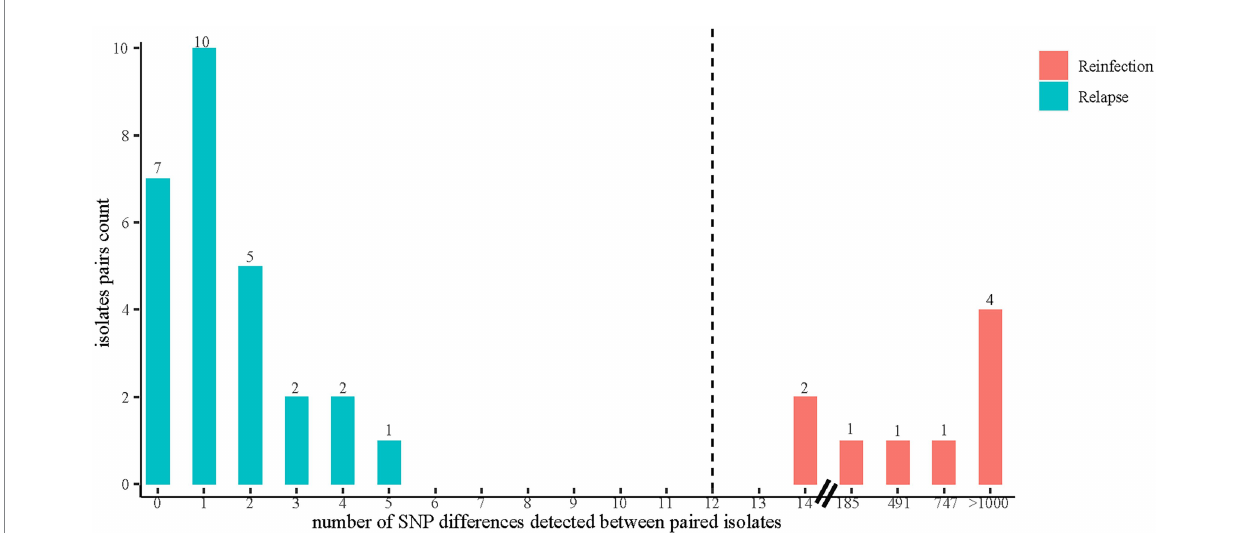
FIGURE 2 The distribution of SNP differences between paired isolates. Reinfection was defined as a recurrent disease episode caused by a new TB strain with a genetic distance of more than 12 SNPs compared with the strain that caused the original episode. Relapse was defined as a genetic distance of 12 or fewer SNPs between paired strains isolated from two episodes in TB recurrence. The SNP differences between paired isolates were calculated by using Snp-dists (v.0.8.2).